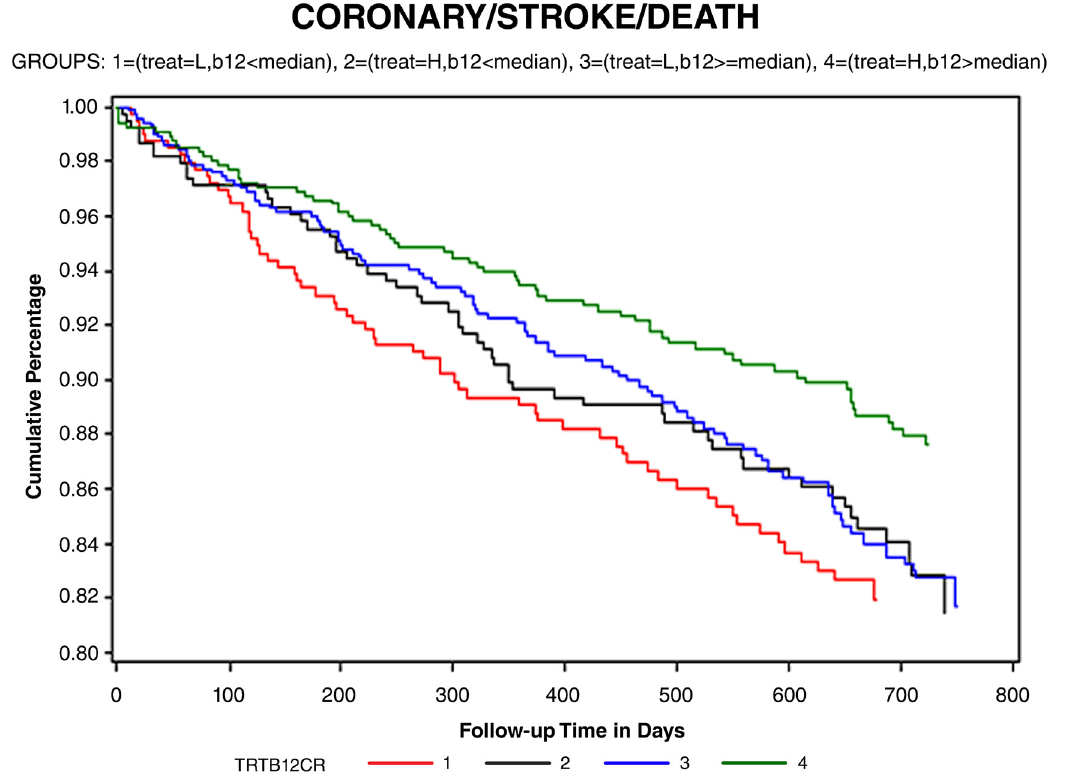
Figure 1. Kaplan-Meier survival free of stroke/myocardial infarction/vascular death in the Vitamin Intervention for Stroke Prevention (VISP) trial excluding patients who received vitamin B12 injections outside the randomized therapy and those with impaired renal function (estimated glomerular filtration rate <46 mL/minute/1.73 m²). Participants were stratified by the median baseline serum B12 level (to characterize the adequacy of B12 absorption) and by randomized allocation to low-dose B vitamins versus high-dose B vitamins (B6 25 mg, B12 400 μg, and folic acid 2.5 mg versus B6 200 μg, B12 6 μg, and folic acid 20 μg daily). The red line represents low-dose vitamins/B12 <median, the green line is high-dose vitamins/B12 above the median, the blue line is low-dose vitamins/B12 above the median, and the black line is high-dose B vitamins/B12 below the median. There was a 34% reduction of the composite endpoint of stroke/myocardial infarction/vascular death in the group with adequate B12 absorption receiving high-dose B vitamins (green line) and the group with less adequate B12 absorption receiving low-dose vitamins. The log-rank p value for all four groups was 0.02. CI, confidence interval; HR, hazard ratio. Reproduced by permission of Wolters Kluver from